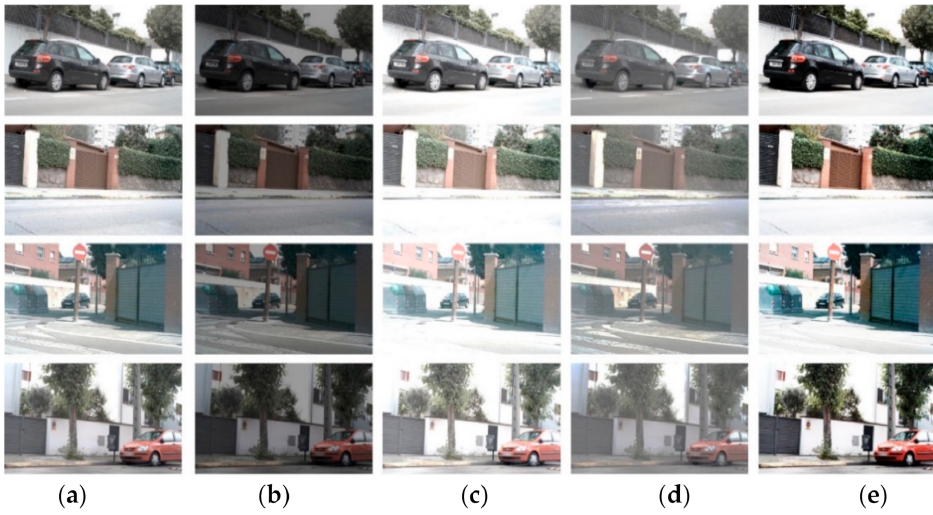
Figure 3. We augment input image data by putting differential in brightness and contrast using BIPED dataset. For more augmentation, it can be adjusted each and simultaneously on original image: ( a ) original image; ( b ) controlled image (darker); ( c ) controlled image (brighter); ( d ) controlled image (low contrast); ( e ) controlled image (high